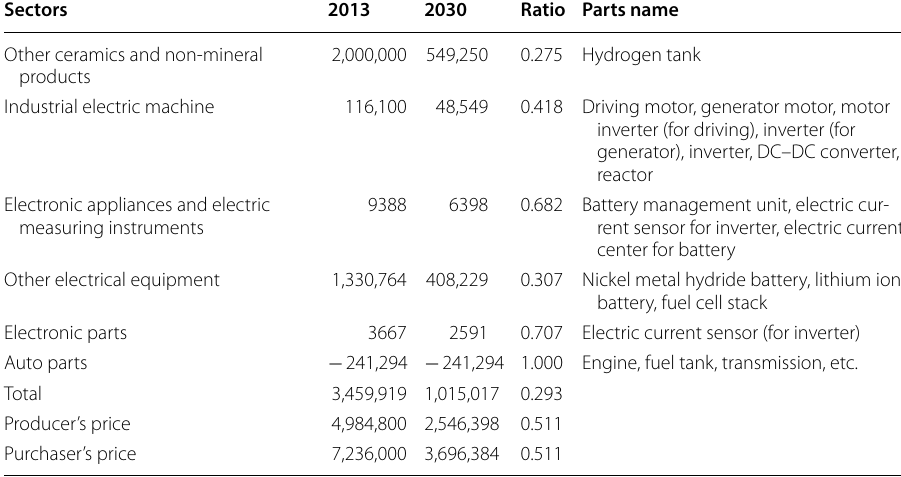
Year “2013” is set as an estimation year in the original table of CRISER (2015), though FCV “Mirai” of Toyota Motor Co. released in 2014